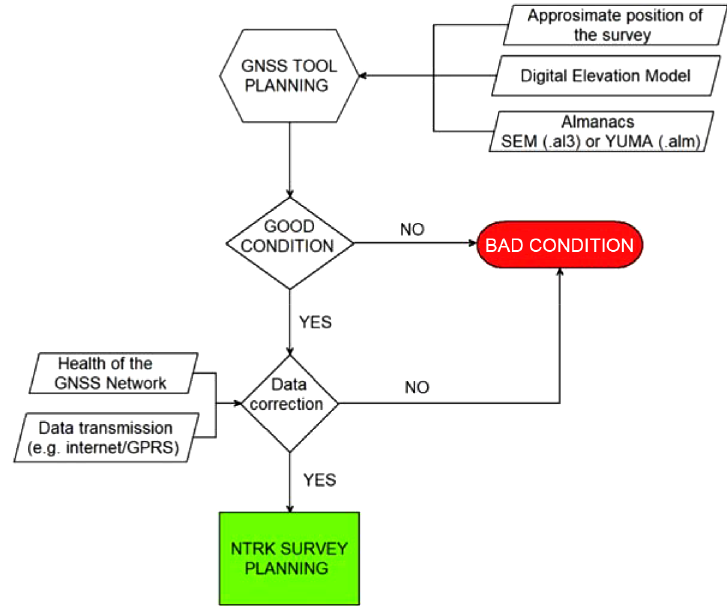
Figure 2. Workflow of NRTK survey